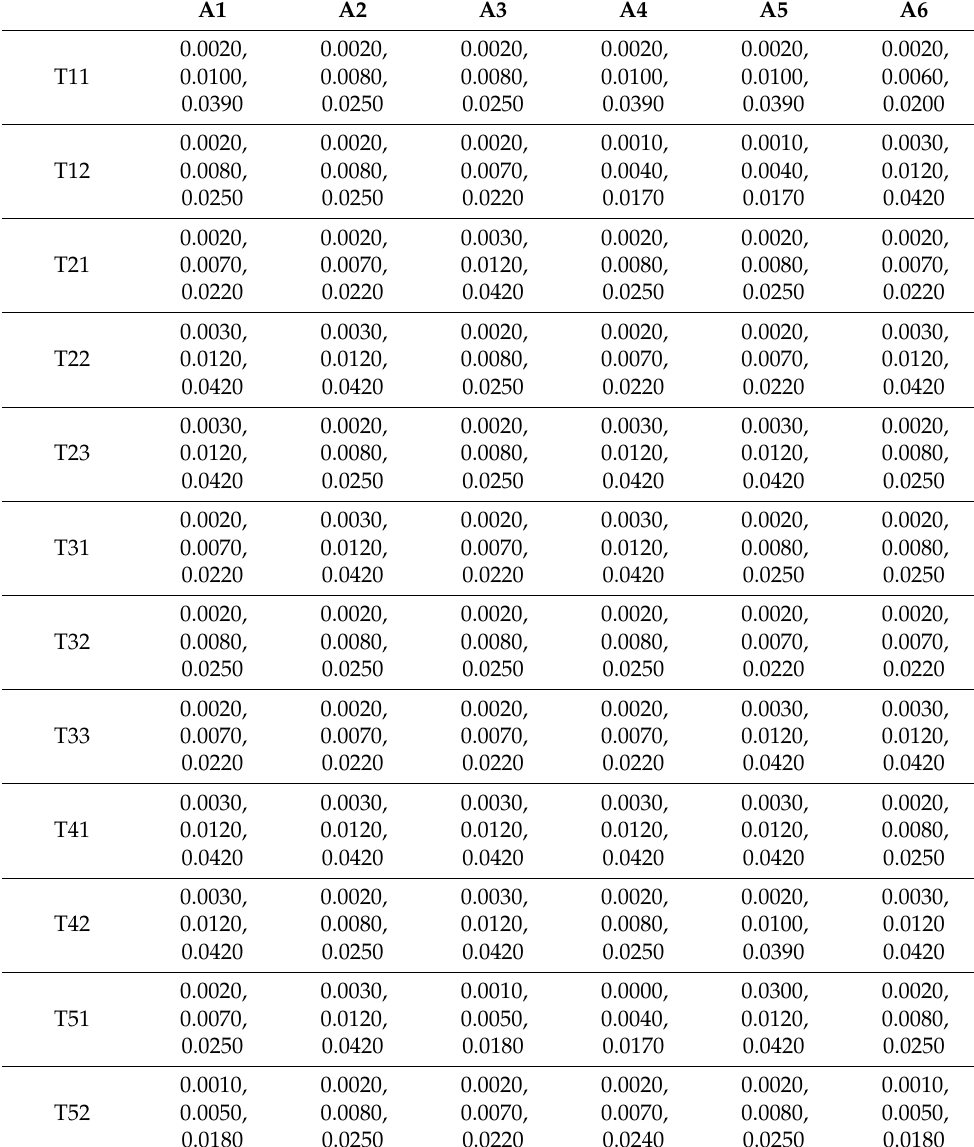
Table 16. The weighted normalized fuzzy decision matrix.